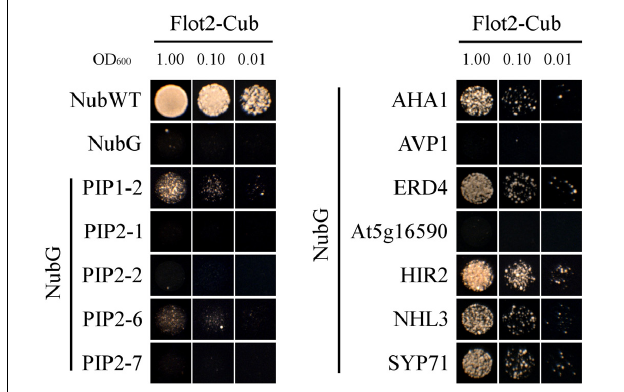
FIGURE 4 | SUS test. Yeast strain THY.AP4 co-expressing Flot2-Cub-PLV and Nub fused with investigated possible interactors were plated in decimal dilution (OD 600 = 1.00 or 0.10 or 0.01) onto selective media (without Ade, His, Leu, Trp) which was supplemented with 50, 250, or 500 µ M Met in order to obtain a different expression level of the bait. Yeast growth rate was gradually repressed with an increasing concentration of Met. Only plates with 500 µ M Met are presented. Plates were incubated for 48 h at 28 ◦ C. NubWT and NubG as prey were used as positive and negative controls, respectively. Similar growth performance was observed for each interaction with at least three biological